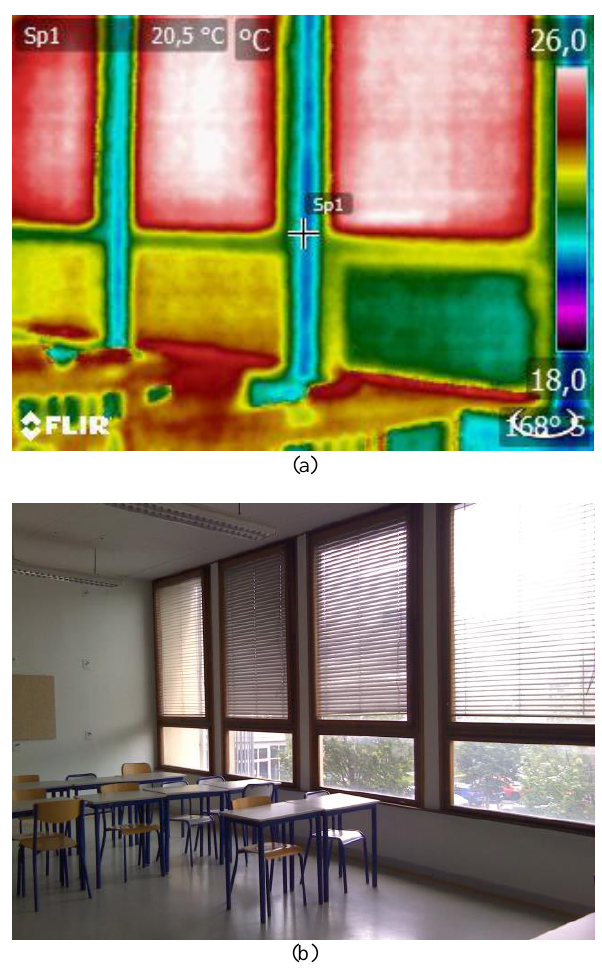
Figure 2. Data acquisition with the thermal camera: (a) infrared image (320×240); (b) corresponding RGB image